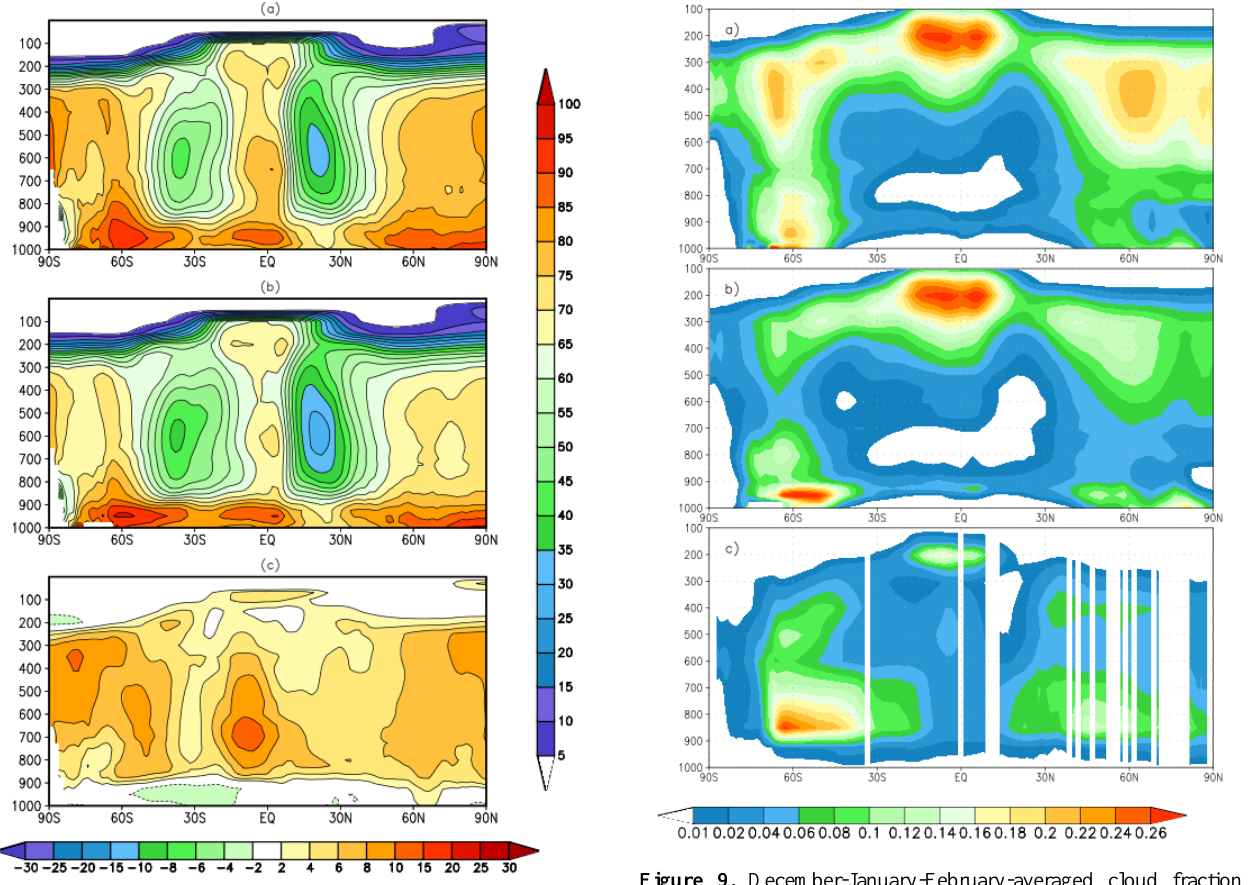
Figure 8. December-January-February-averaged relative humidity in percent from (a) experiment 5 (MERRA AGCM-like), (b) exper- iment 4 (MERRA2 AGCM-like) and (c) the difference of experi- ment 5 minus experiment 4.